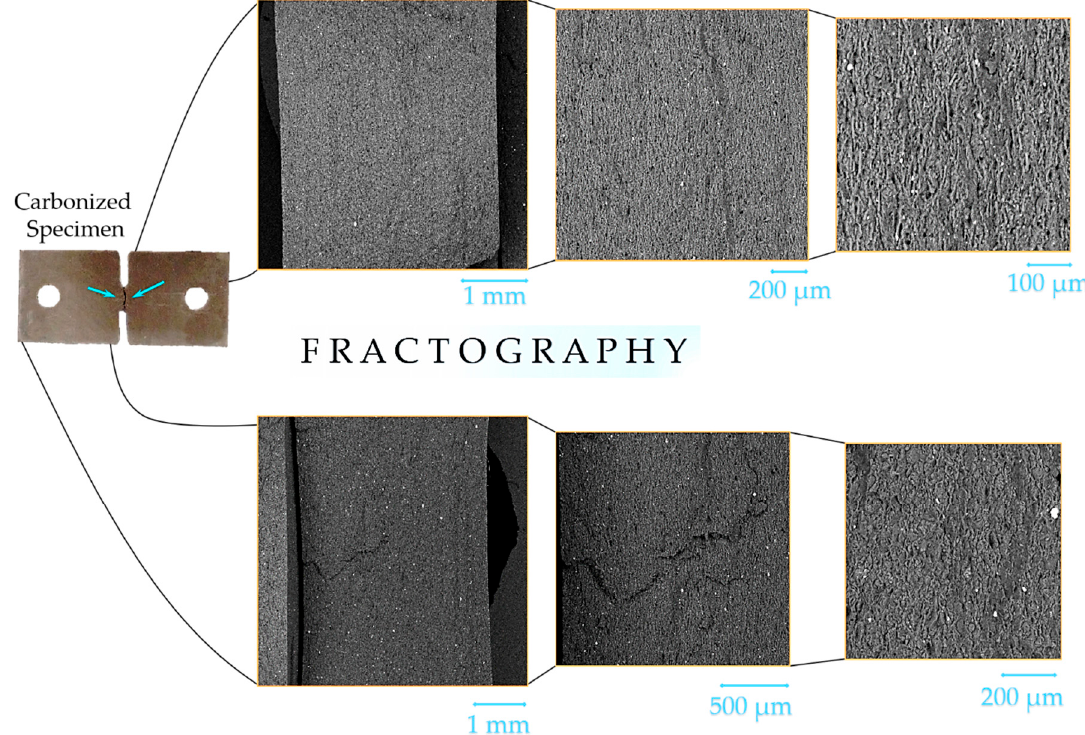
Figure 16. An example of fractography analysis in carbonized elastomer-based composites (CEC) specimens.